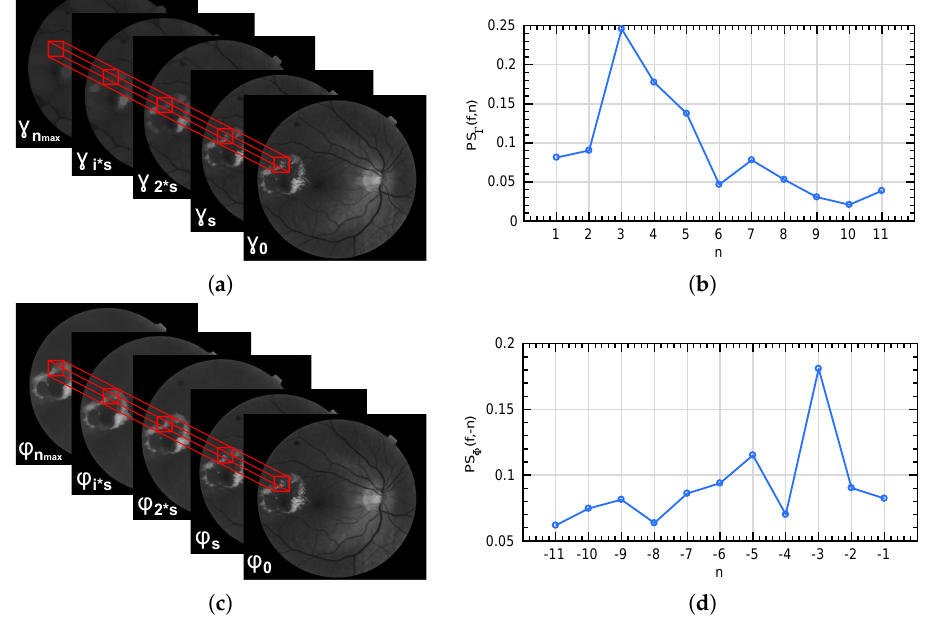
Figure 7. ( a,c ) represent the local extraction of the granulometry and anti-granulometry curves from the morphological pyramids Π γ and Π ϕ . ( b,d ) show the pattern spectrum computed for the patch marked in red in each case.